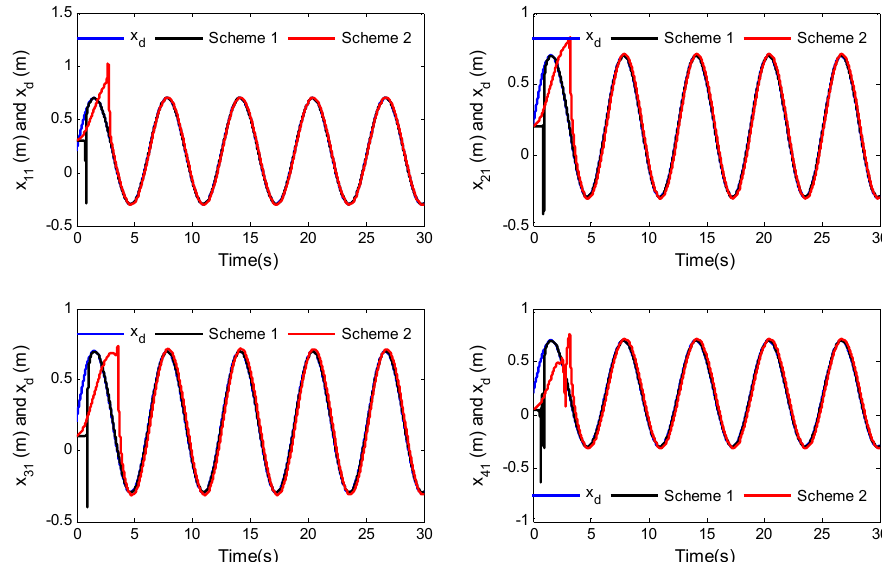
Figure 17. The comparison results of output x i 1 .